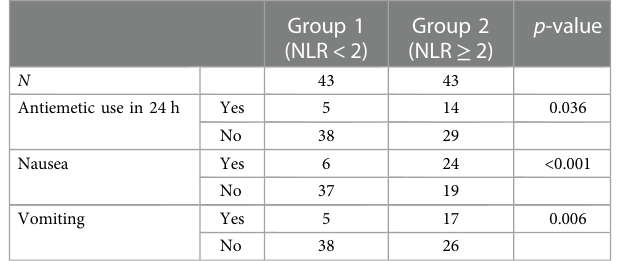
TABLE 1 Comparison of baseline characteristics and surgical information between the two groups of